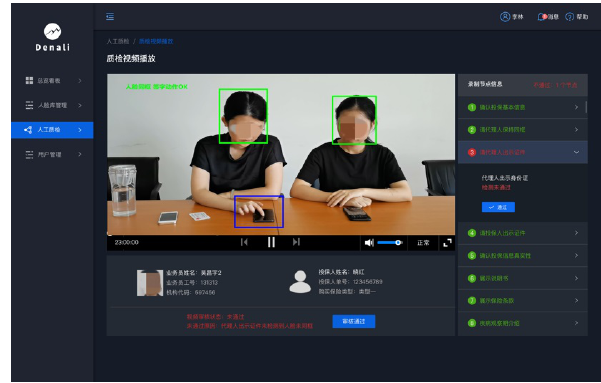
Fig. 6 Video playback interface for dual-recording at backstage quality